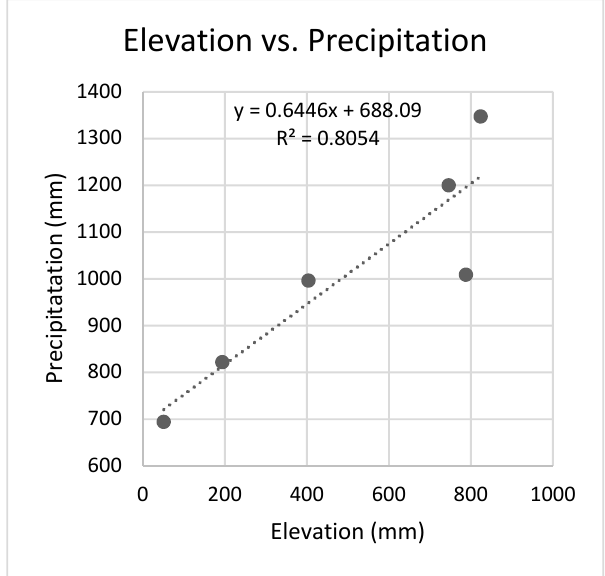
Figure 8. Mean annual precipitation (1995–2012) vs. elevation of the CFSR grid for the Melen Watershed.